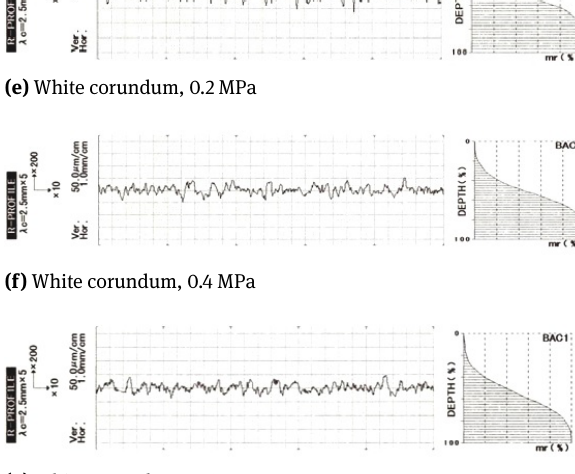
Figure 3: Profiles of materials as-made and blasted. an increasing of RSm parameter at all air pressures by more than 100%, the value of the parameter RPc analog- ically decreased.